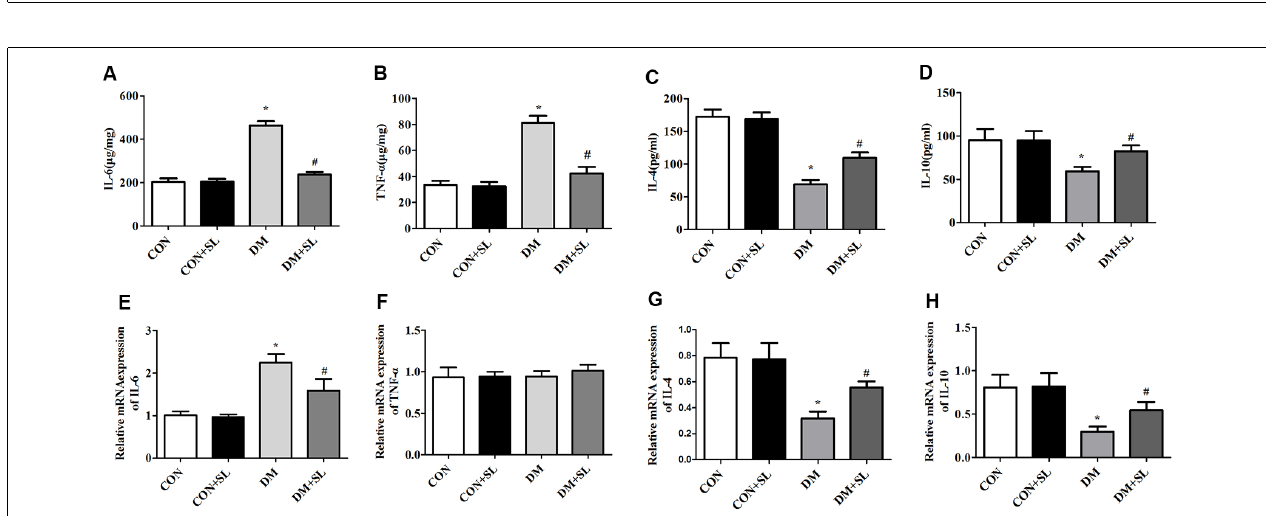
FIGURE 5 | Effect of strawberry leaf extract on IL-6, TNF- α , IL-4, and IL-10 in the four groups. The data in each group are shown as the mean ± SD. (A) Expression of mIL-6. (B) Expression of mTNF- α . (C) Expression of mIL-4. (D) Expression of mIL-10. (E) Content of IL-6. (F) Content of TNF- α . (G) Content of IL-4. (H) Content of IL-10. * p < 0.05 vs. CON group; # p < 0.01 vs. DM group, n = 5.